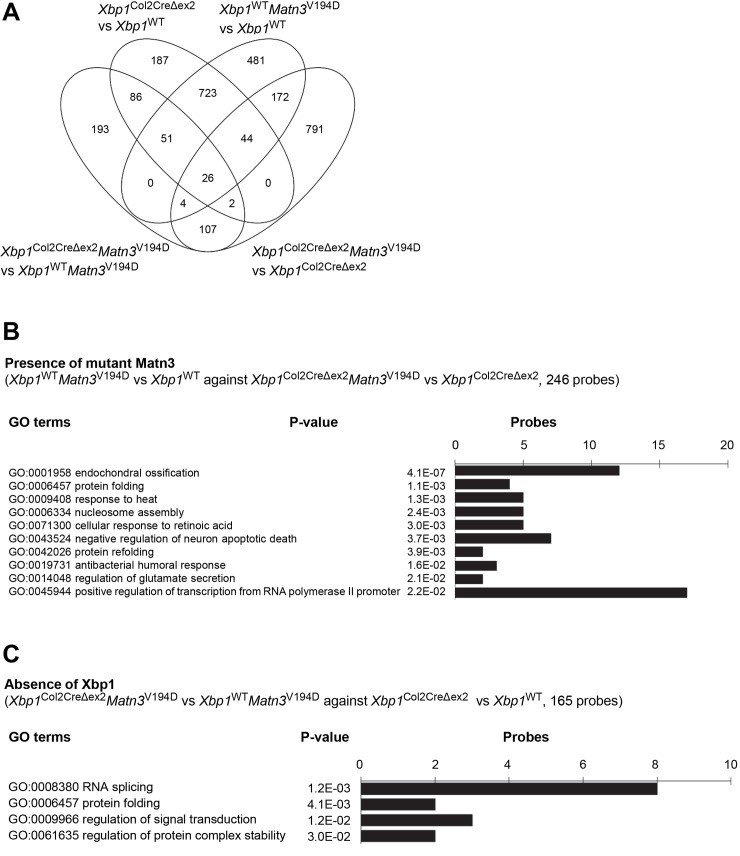
(A) Venn diagram showing an overlap in the significantly downregulated microarray probes from the 4 analyses (Xbp1WT
Matn3V194D vs Xbp1WT, Xbp1Col2CreΔex2
Matn3V194D vs Xbp1Col2CreΔex2, Xbp1Col2CreΔex2
Matn3V194D vs Xbp1WT
Matn3V194D and Xbp1Col2CreΔex2 vs Xbp1WT. (B) A graph showing the GO terms associated with 47 downregulated probes representing the XBP1 independent effect of a MATN3 mutation. (C) A graph showing the GO terms associated with 62 downregulated probes representing the MATN3 mutation independent effect of XBP1 deletion.